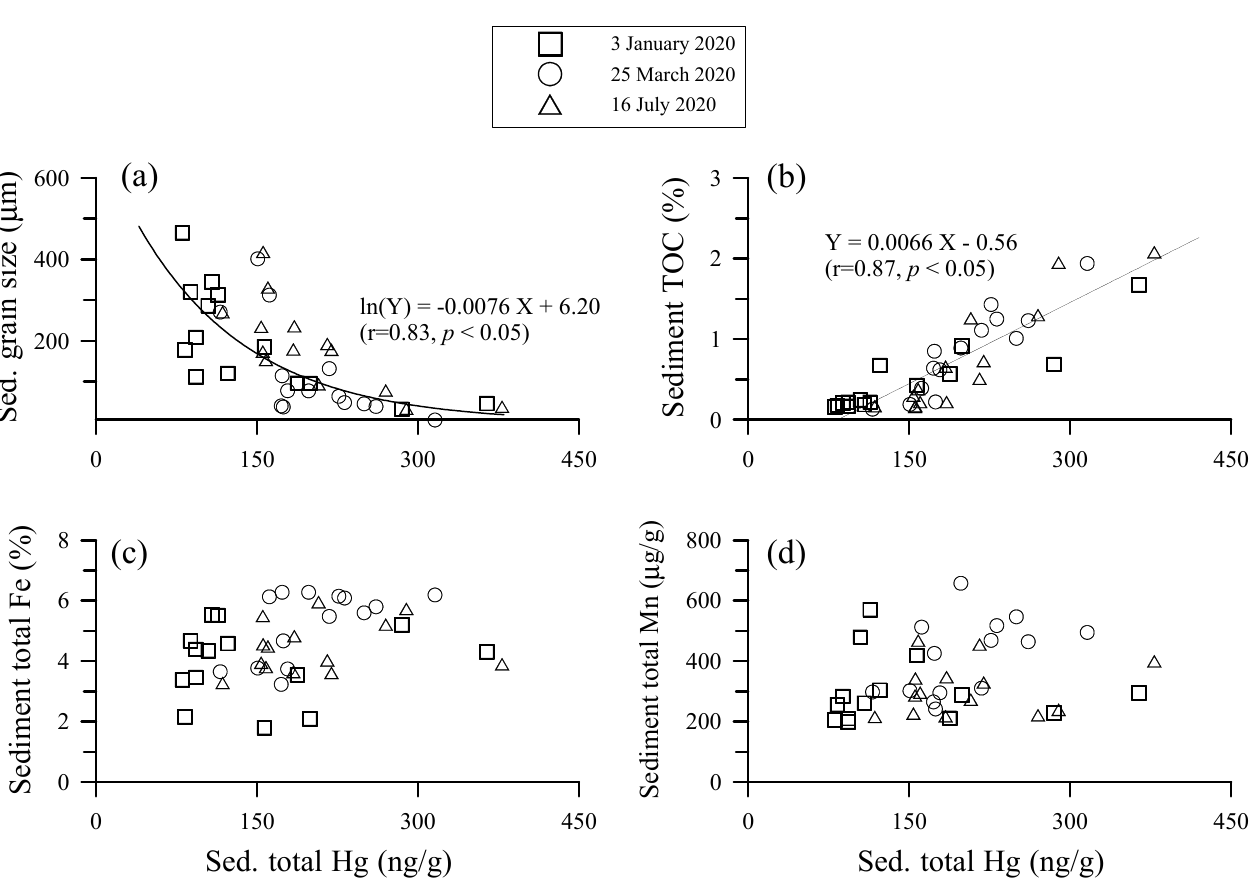
Figure 8. Scatter plots of ( a ) sediment grain size, ( b ) sediment TOC, ( c ) sediment Fe, and ( d ) sediment Mn against sediment total Hg concentrations in the Danshuei River Estuary, northern Taiwan.